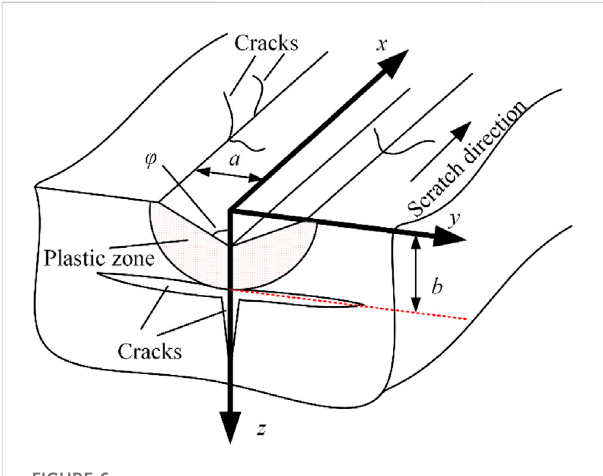
FIGURE 6 The schematic of the plastic zone and cracks caused by a sharp diamond